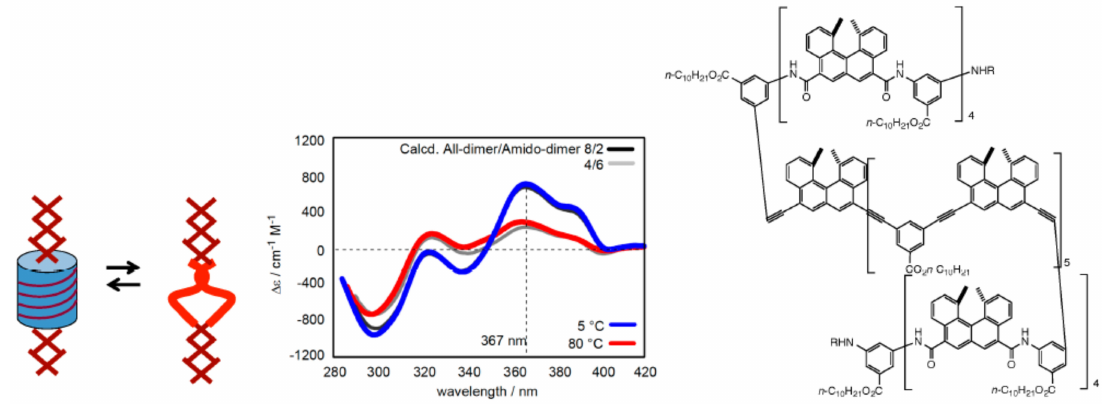
Figure 17. Expand and shrink of a tri-domain ( P , P , P )-oligomer as shown by CD spectra. Chemical structure of tri-domain ( P , P , P )-oligomer is also